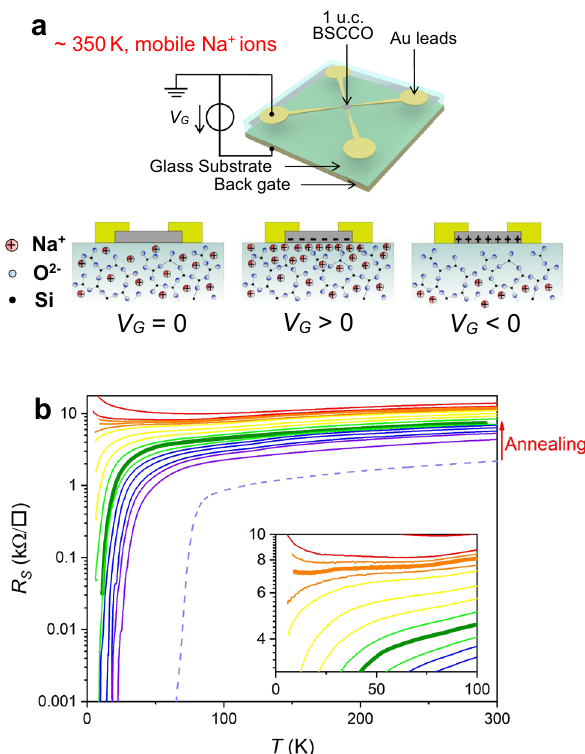
Fig. 1 Superconductor-insulator transition driven by space charge doping. a Schematic view of the device and of the space charge doping method 23 . b Temperature dependence of R S curves induced by space charge doping for device F. The thick olive green R S ( T ) curve is the initial sheet resistance of the sample after annealing to reduce doping whereas the dashed violet curve is representative of the optimal doping level of 1 u.c. BSCCO after fabrication by anodic bonding. The inset shows a blow-up and the thick orange “ horizontal ” curve approximately corresponding to the critical doping.